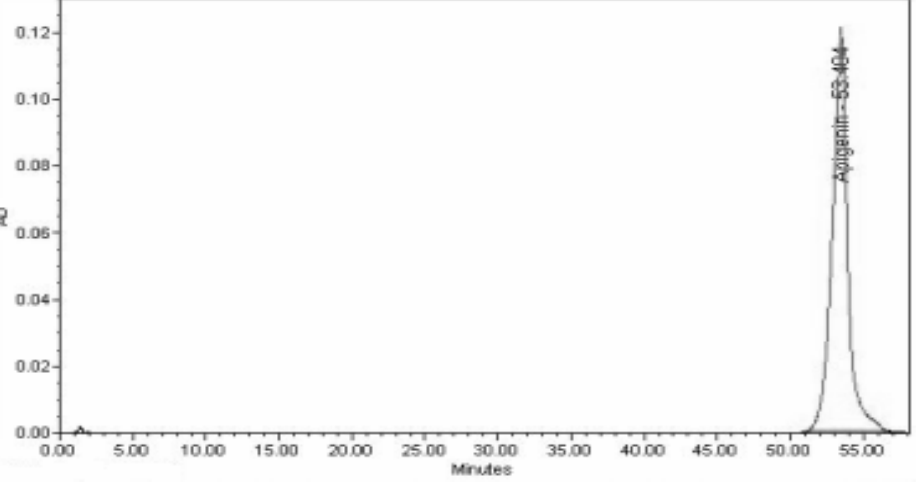
Figure 4. Standard of Apigenin at 340